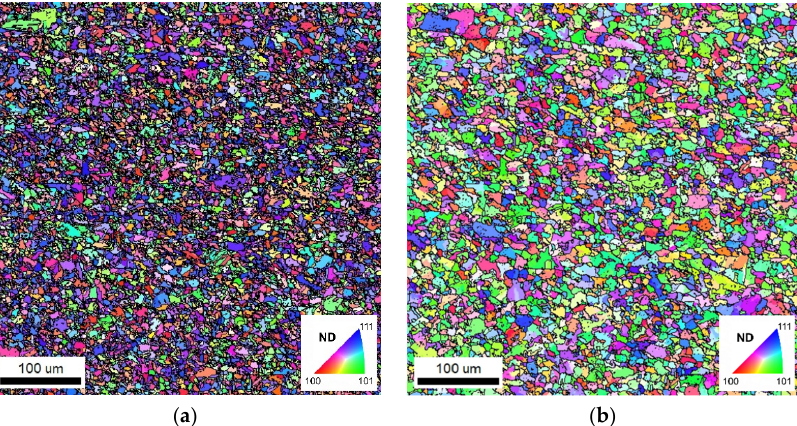
Figure 5. ( a ) Experimentally measured OIM map of a martensitic Fe-8.5Cr alloy and ( b ) reconstructed parent austenite map obtained with OIMv8.6 ® software.